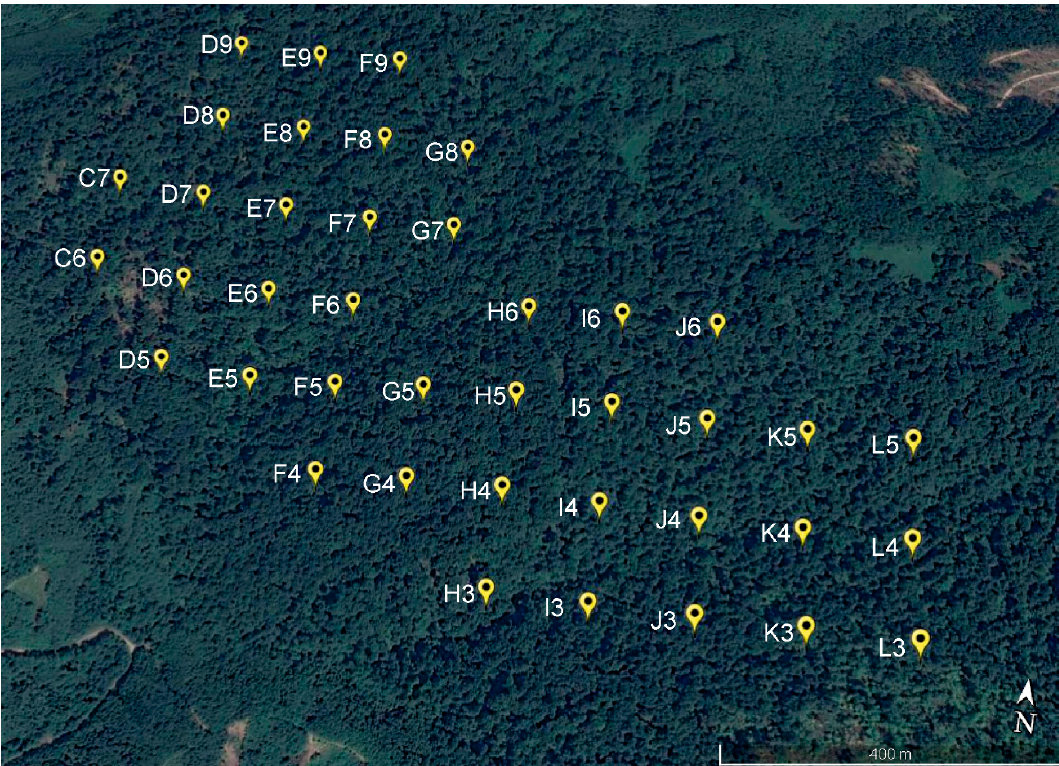
Figure 1. Position of 40 plots for electrical resistivity measurement (Google Earth, Google LLC).